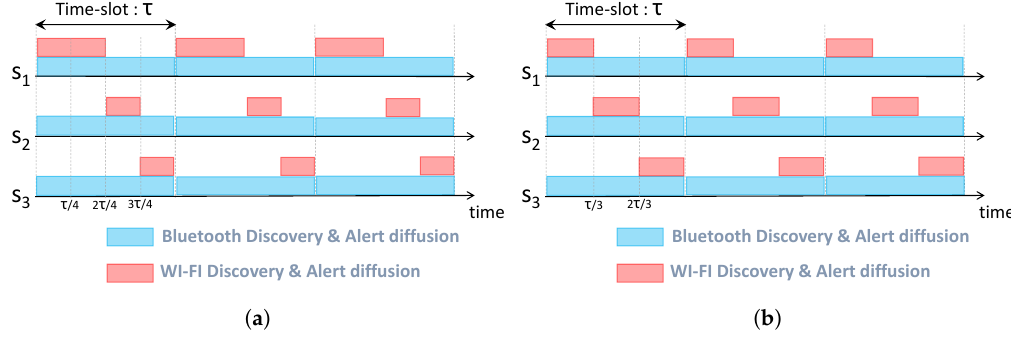
Figure 7. Alert diffusion schedule inside Room 1. ( a ) Before energy balance; ( b ) After energy balance.